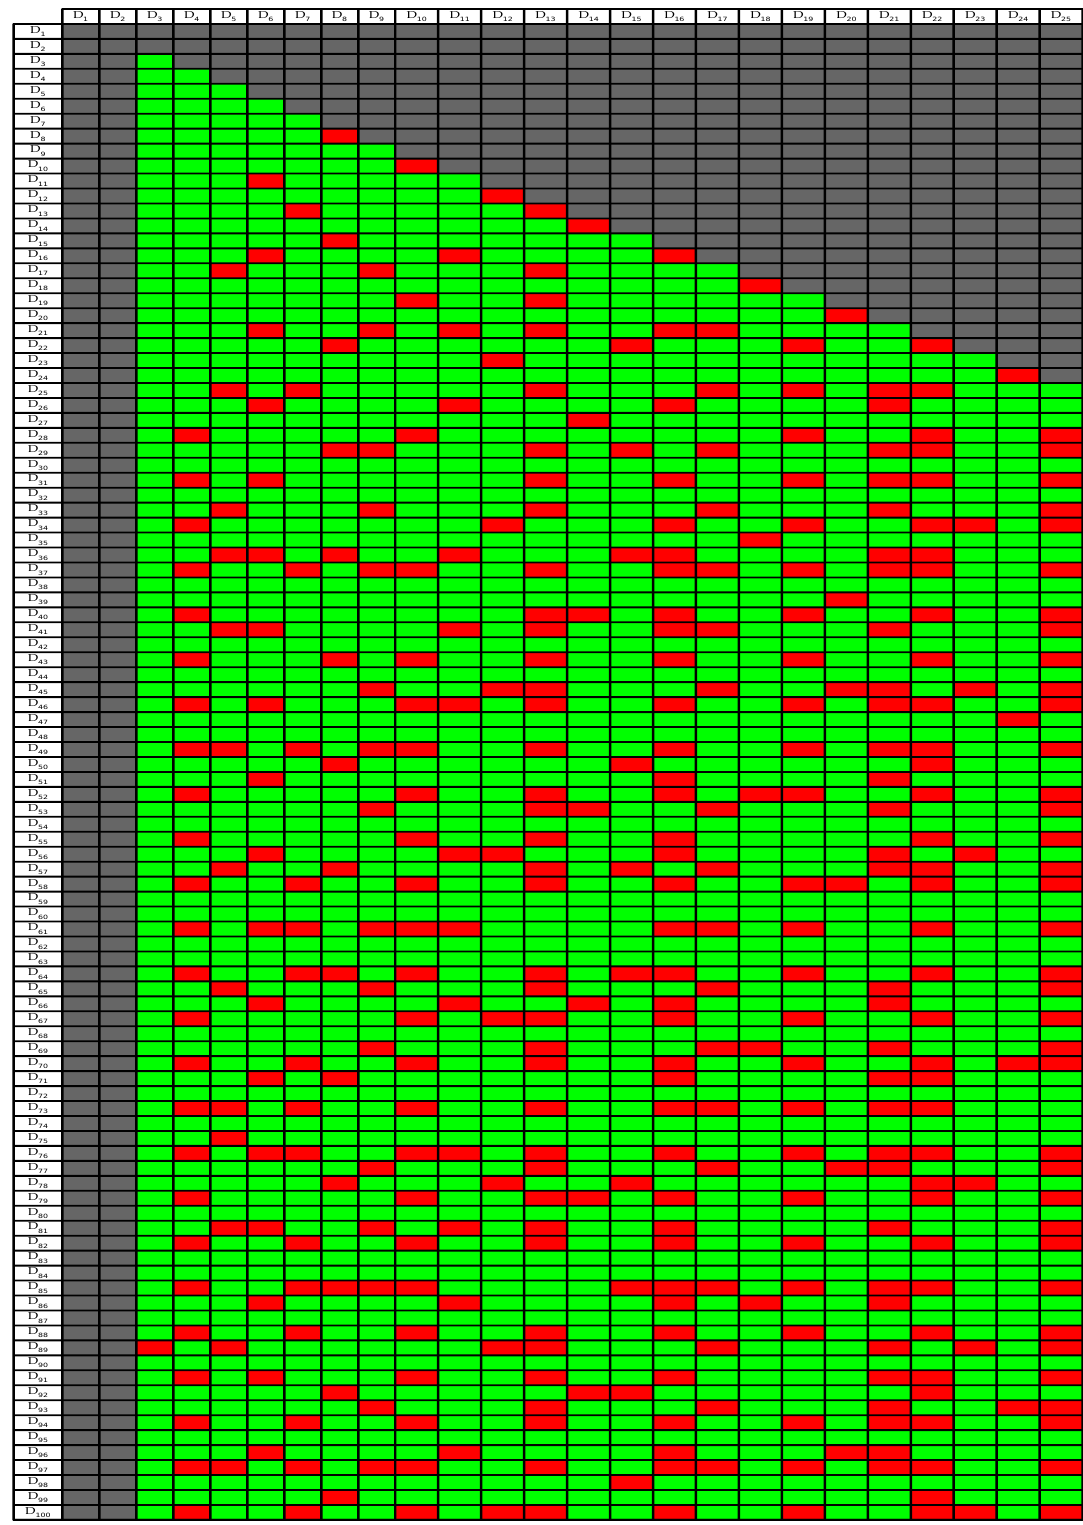
Table 10 . Analyzed theories for ( D n ; D m ) with n = 3 ; : : : 100 and m = 3 ; : : : 25.